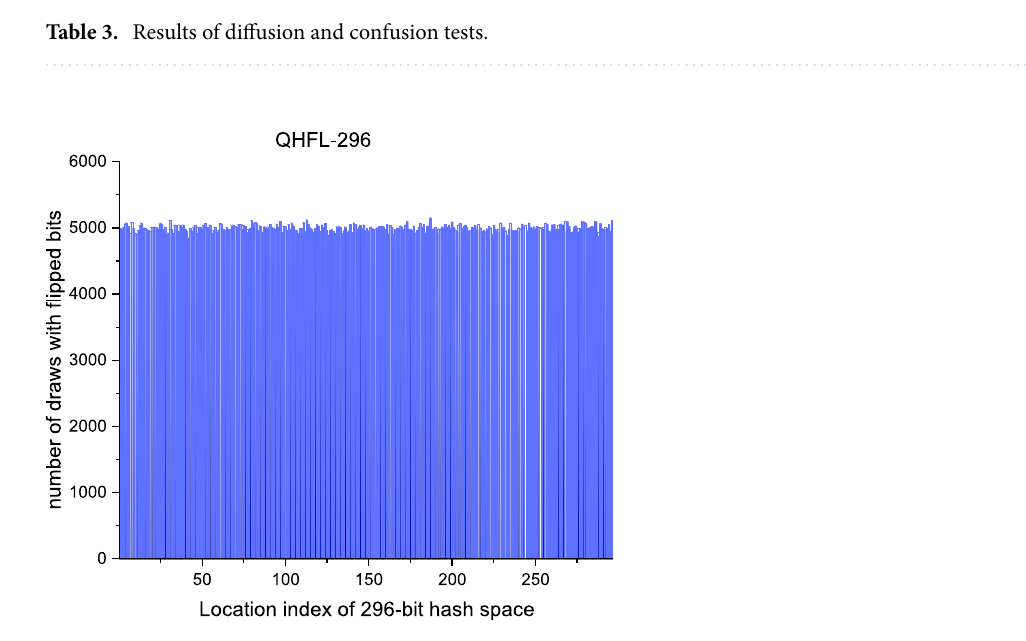
Figure 2. Histogram of the 296-bit hash